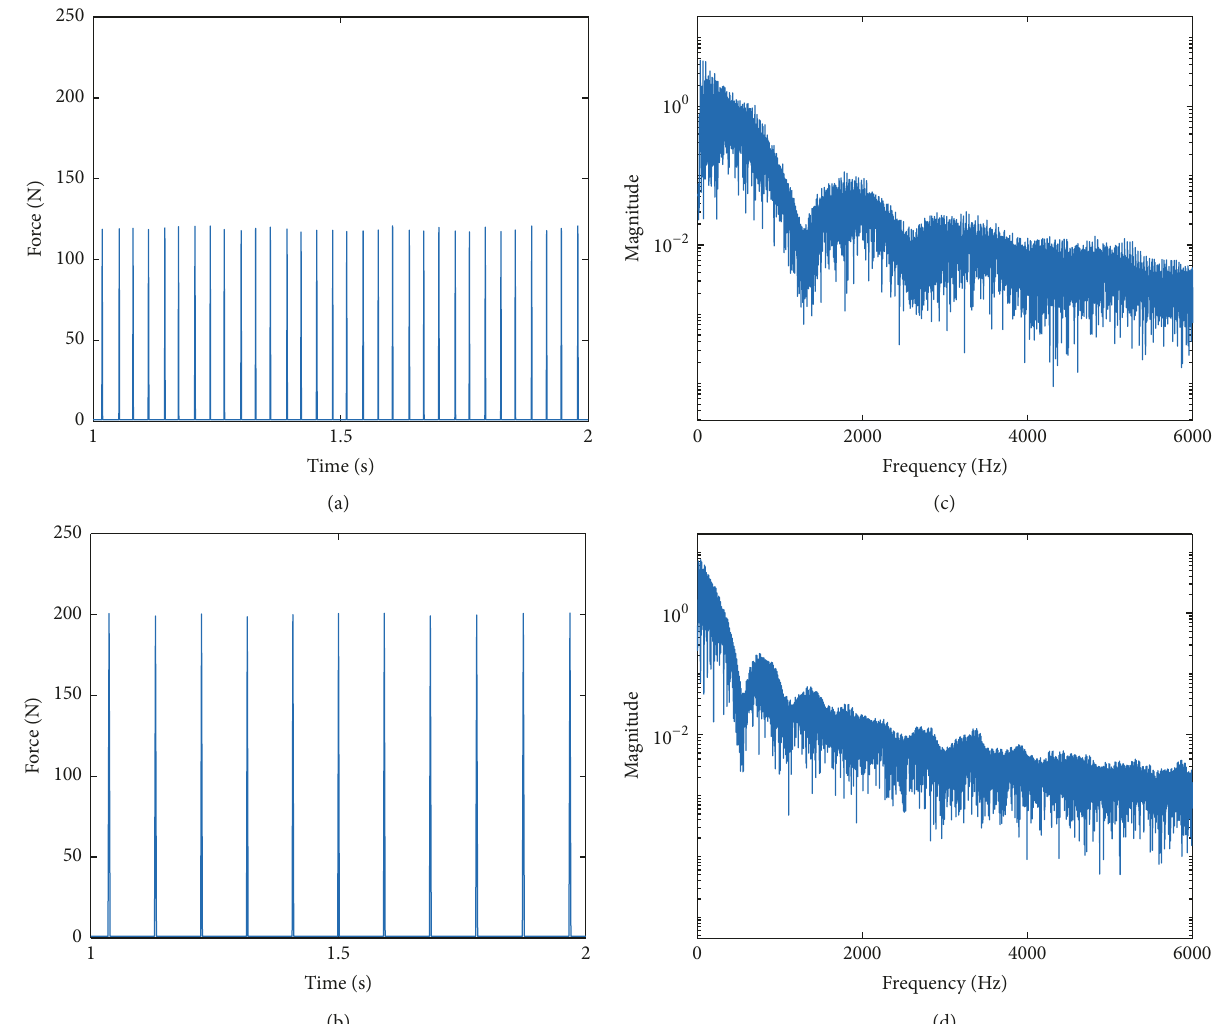
Figure 9: Illustration of the excitation forces to B1 and B3 in the time domain in (a) and (b), and in the frequency domain in (c) and (d),